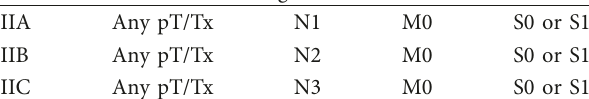
Table 2: Stage II